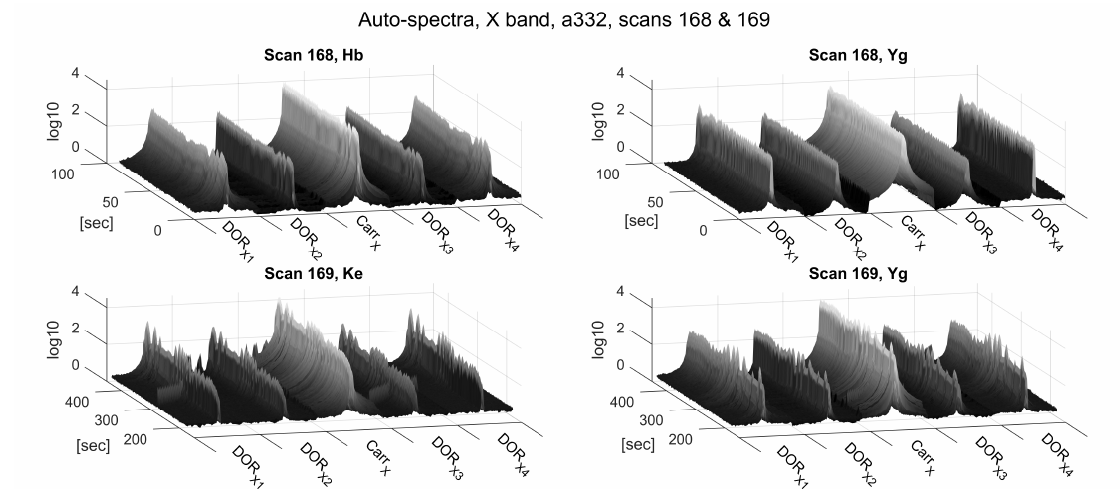
Figure 5. Auto-spectrum magnitudes of the X-band zoom-bands of Scans 168 (upper panels) and 169 (lower panels) of Experiment a332. The frequency axes (horizontal axes) depict the five 32 kHz wide DiFX zoom-bands described in Table 3 next to one another. The time axes indicate seconds since the start of Scan 168 (10:41:04 UTC).